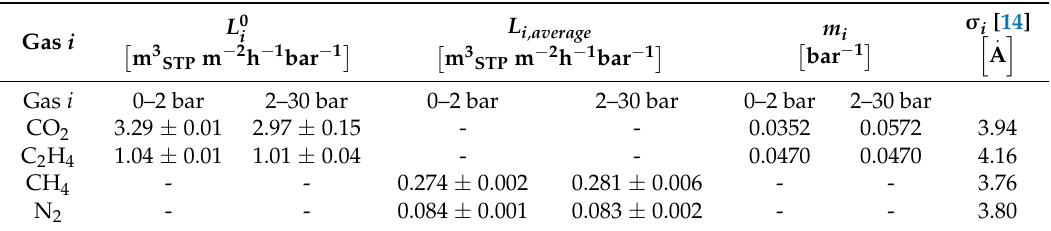
Table 1. Free Volume Model parameters determined from single gas measurements at 25 ◦